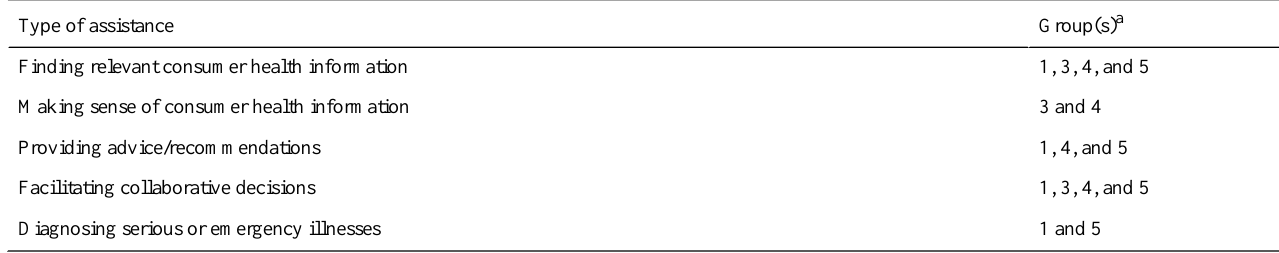
Table 1. Types of assistance that groups mentioned when describing their intelligent assistant concept.